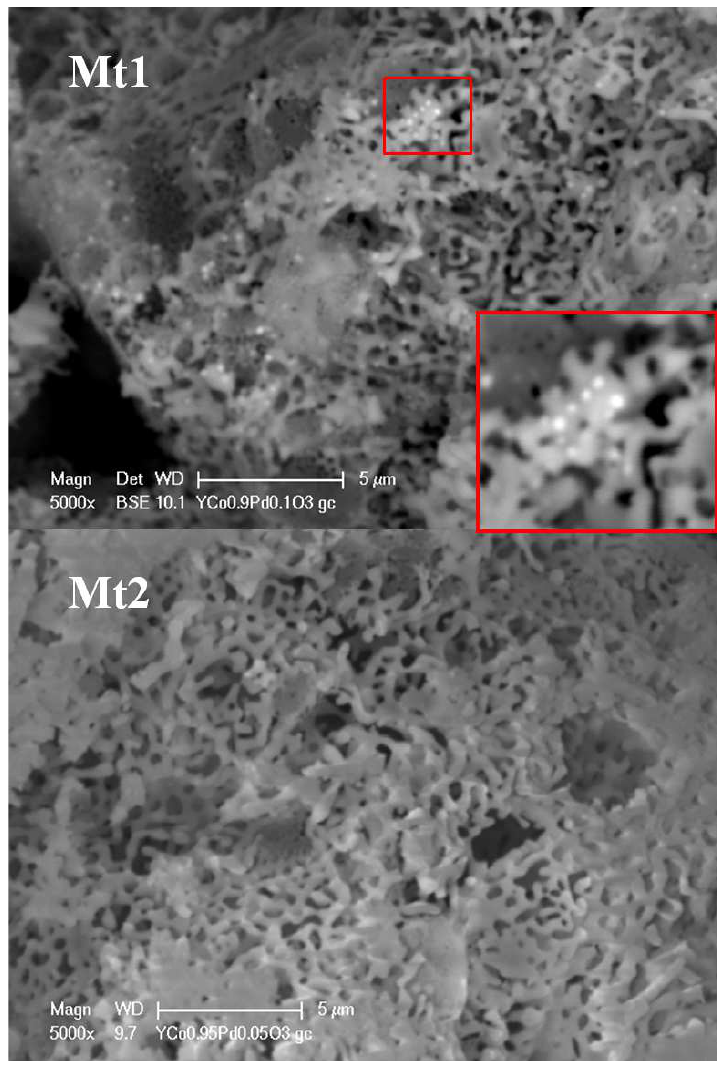
Figure 3. SEM: morphology analysis of Mt1 and Mt2 at 5000 ×